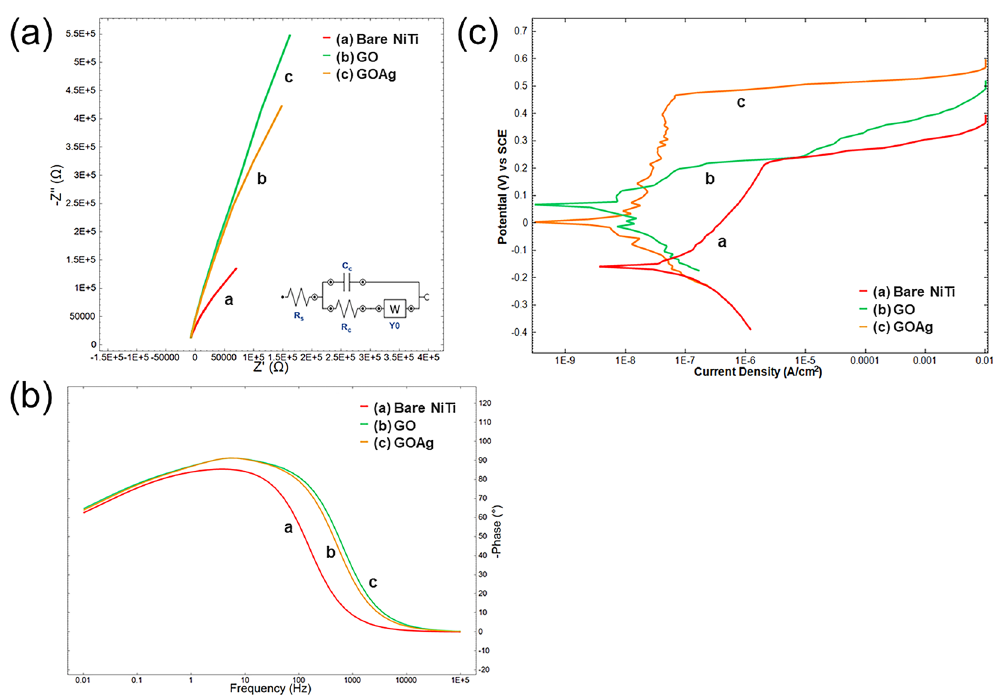
Figure 5. ( a ) Nyquist plots with equivalent circuit model, ( b ) Bode plots for the bare NiTi, GO-coated NiTi (GO) and GO/Ag-coated NiTi (GOAg) alloy, and ( c ) Potentiodynamic polarization curves of the bare NiTi, GO-coated NiTi (GO), and GO/Ag-coated NiTi (GOAg) after immersion in 3.5% NaCl. R s = Electrolyte solution resistance, R ct = Charge transfer resistance of the corrosion reaction, C dl = Capacitance, W = Warburg Impedance related to the diffusion of O 2 of the NiTi alloy, and SCE = saturated calomel